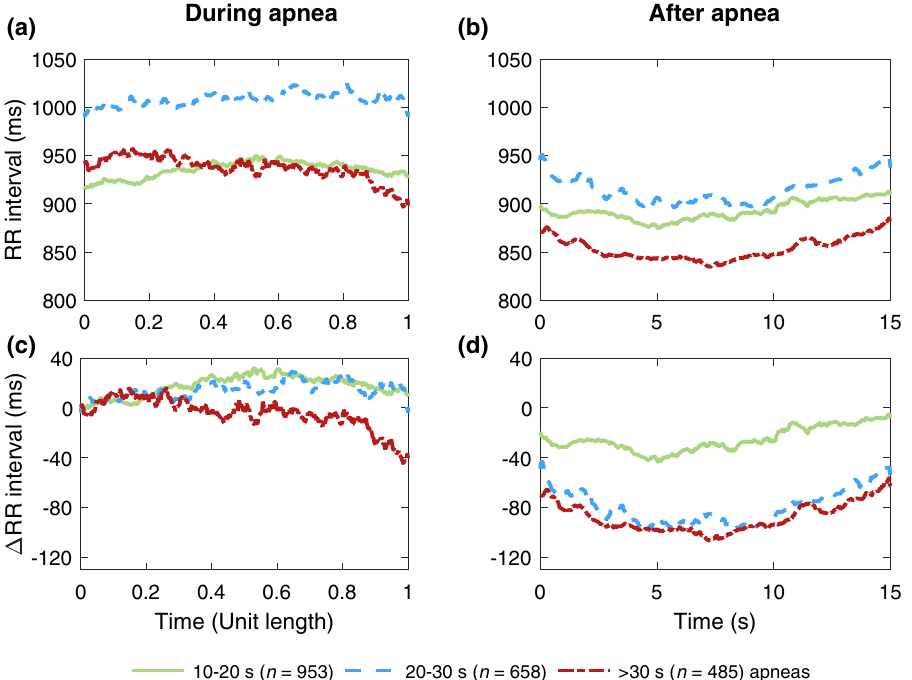
Figure 3. Median RR intervals of women ( n = 232) ( a) during apneas of different durations ( n = 2 096) and ( b) during a 15-s segment following apneas. The absolute change in RR intervals relative to the beginning of the event during and after apneas are presented in subfigures ( c) and ( d) , respectively. In subfigures ( a) and ( c) the duration of every apnea event is normalized with its duration.